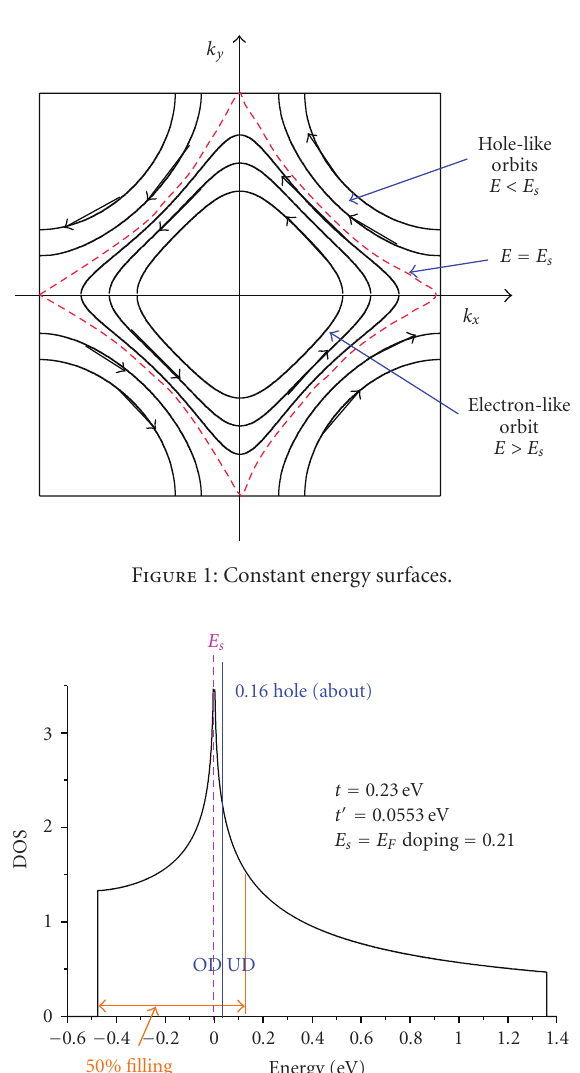
Figure 2: Density of States